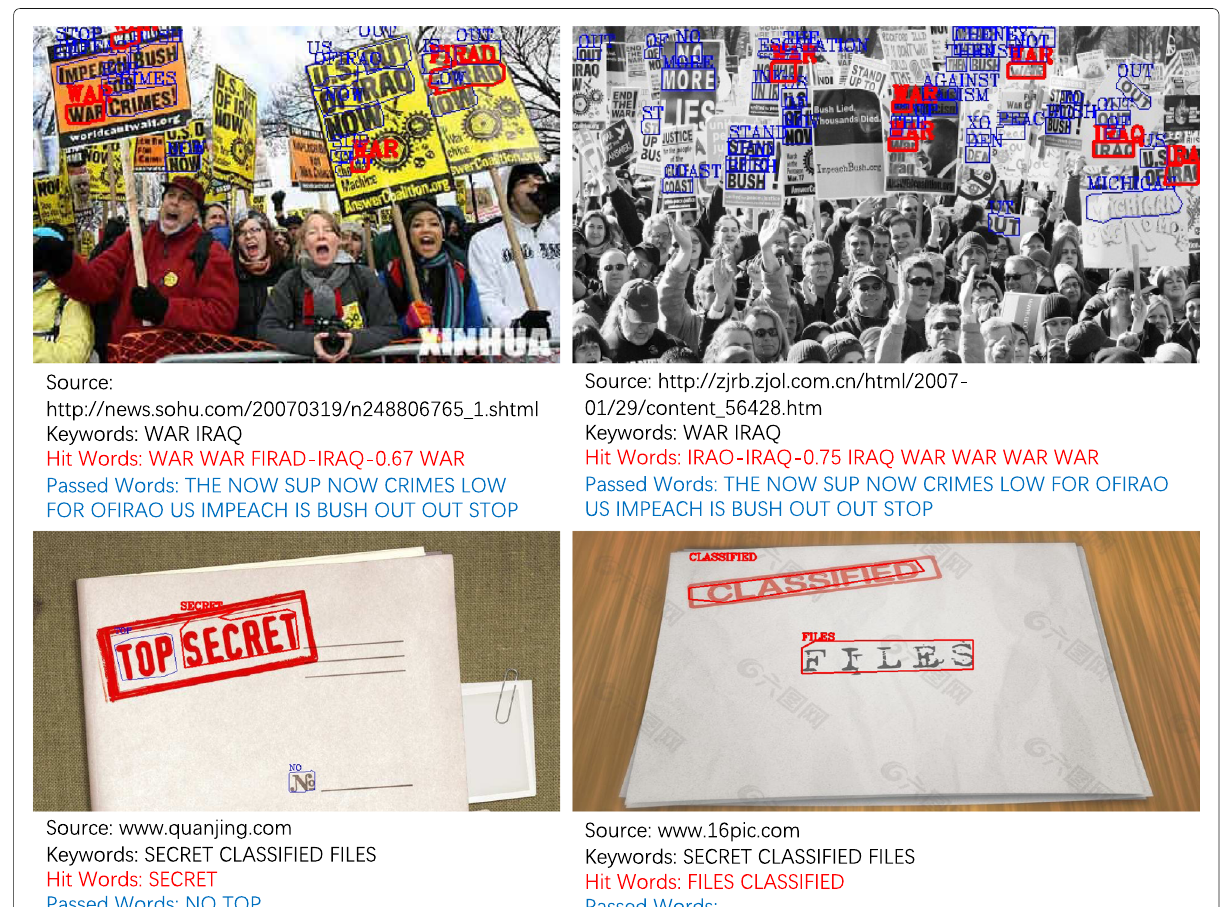
Fig. 8 Keywords checking results from our method in the parade scenario and cover page scenario